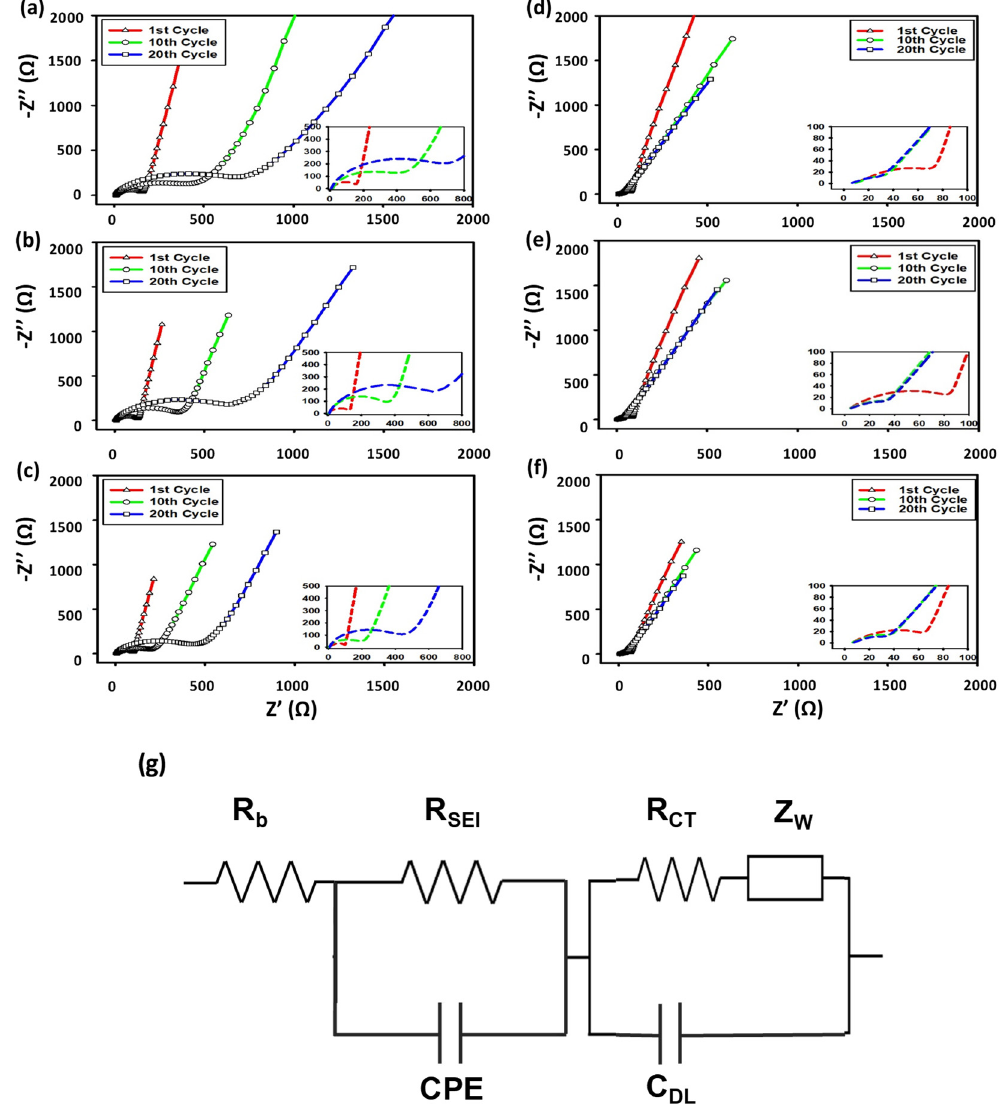
Figure 9. EIS-based Nyquist plots for the SbTe-C20, SbTe-C30, and SbTe-C40 electrodes in cells with 5% FEC added to the electrolyte: ( a – c ) PVDF binder and ( d – f ) PAA binder. ( g ) The equivalent circuit.